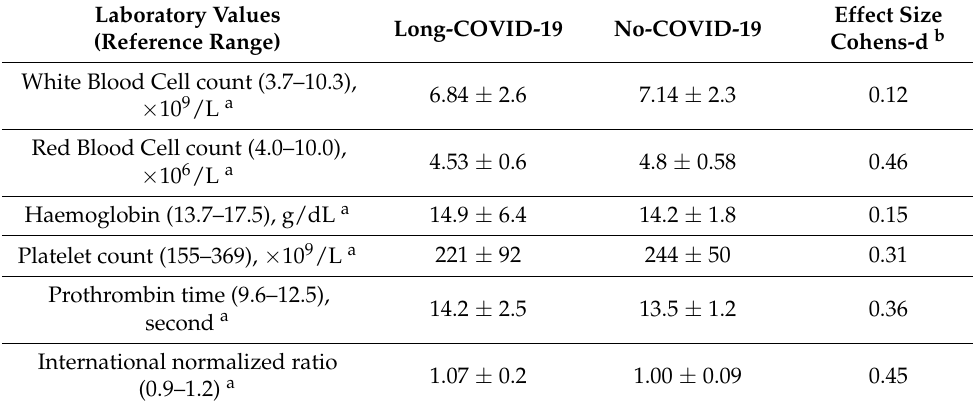
Table 2. Laboratory data of the study